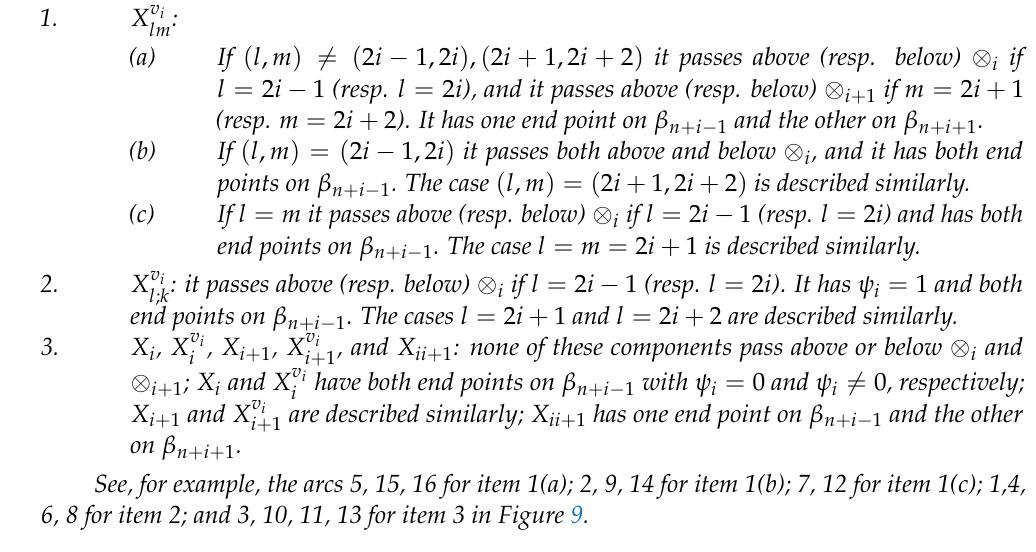
( 1,0;0,1 ) , 7 : X ( 0,1;0,1 ) 2 i 1; i −